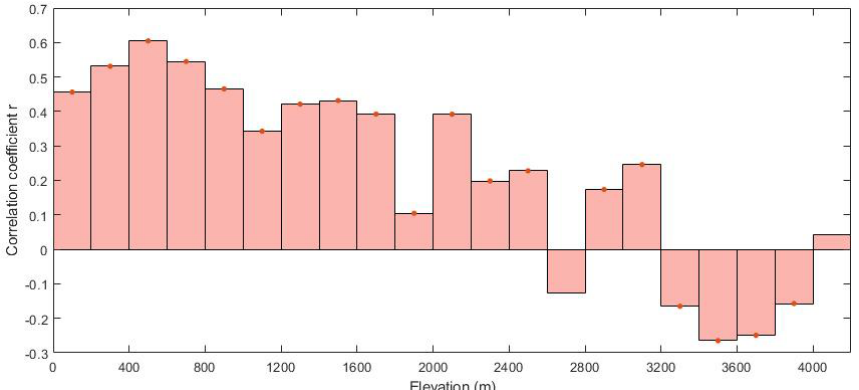
Figure 7. Correlation coefficients of PM 2 . 5 –AOD pairs plotted against binned elevations. Note that the red asterisk indicates the statistically significant level at p <